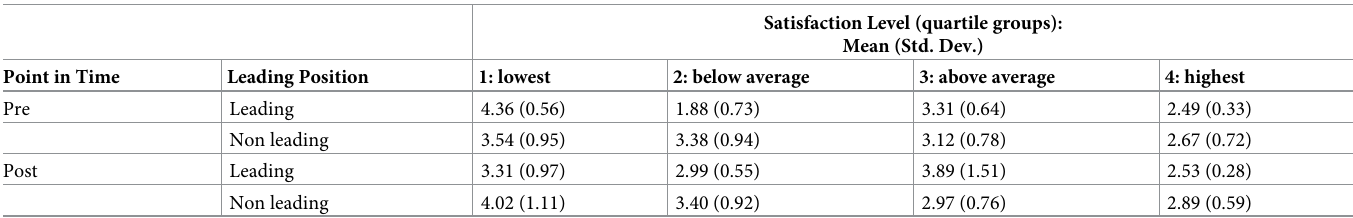
Table 7. Means (and standard deviation) for three-way interaction of point in time (pre vs. post), management position (leading vs. non leading) and satisfaction level (quartile 1 to 4) on active knowledge transfer.